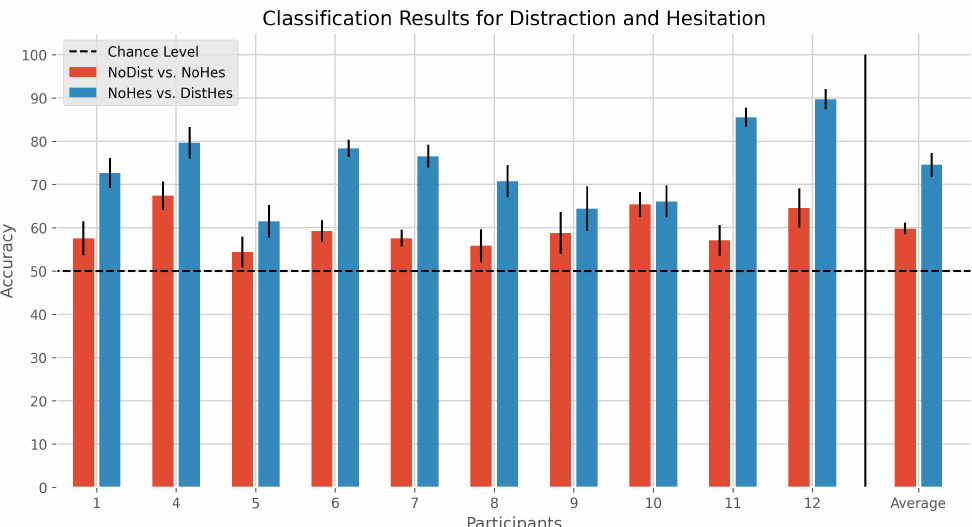
Figure 4. Classification results for 1-second EEG windows of the ambient and distraction conditions (red) and the distraction and hesitation conditions (blue) with standard error bars (black) calculated between the 10 splits of the cross-validation and the random runs.